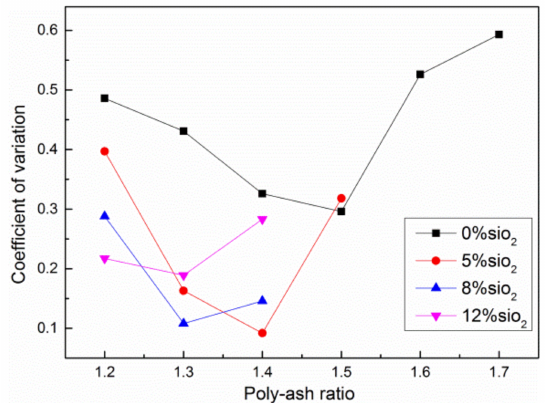
Figure 6. Relationship curve for resistance coefficient of variation and poly-ash ratio in CNFPUC